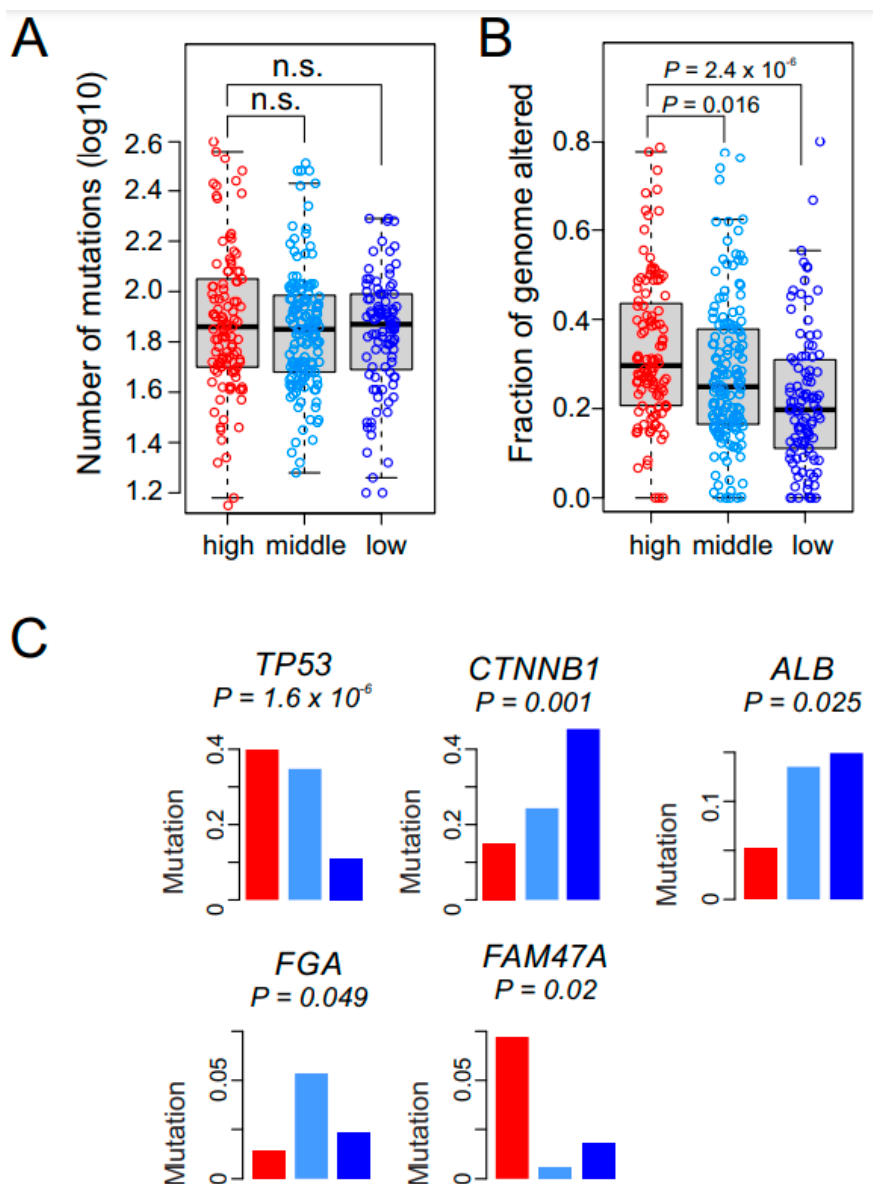
Figure 4. Genomic alterations in the glycolysis metabolic (GM) subtypes. ( A ) Bee swarm box plots for number of nonsynonymous mutations in GM subtypes ( n = 367). No significant difference is observed among the GM subtypes. In the box plots, the boundary of the box indicates the 25th to 75th percentile, and the black line within the box marks the mean. Whiskers above and below the box indicate the 10th and 90th percentiles. Circles represent the number of mutations in each tumor. ( B ) The fraction of the genome altered by copy number gain and loss was estimated by GISTIC2 analysis in each tumor ( n = 367). The high GM subtype has significantly higher alterations than the other two subtypes (all p < 0.05 by Student t test). ( C ) Somatic mutations associated with GM subtypes in TCGA cohort. Mutation rates of each gene are presented as fraction within subtypes. Red, light blue, and dark blue represent the high, middle, and low GM subtypes, respectively.